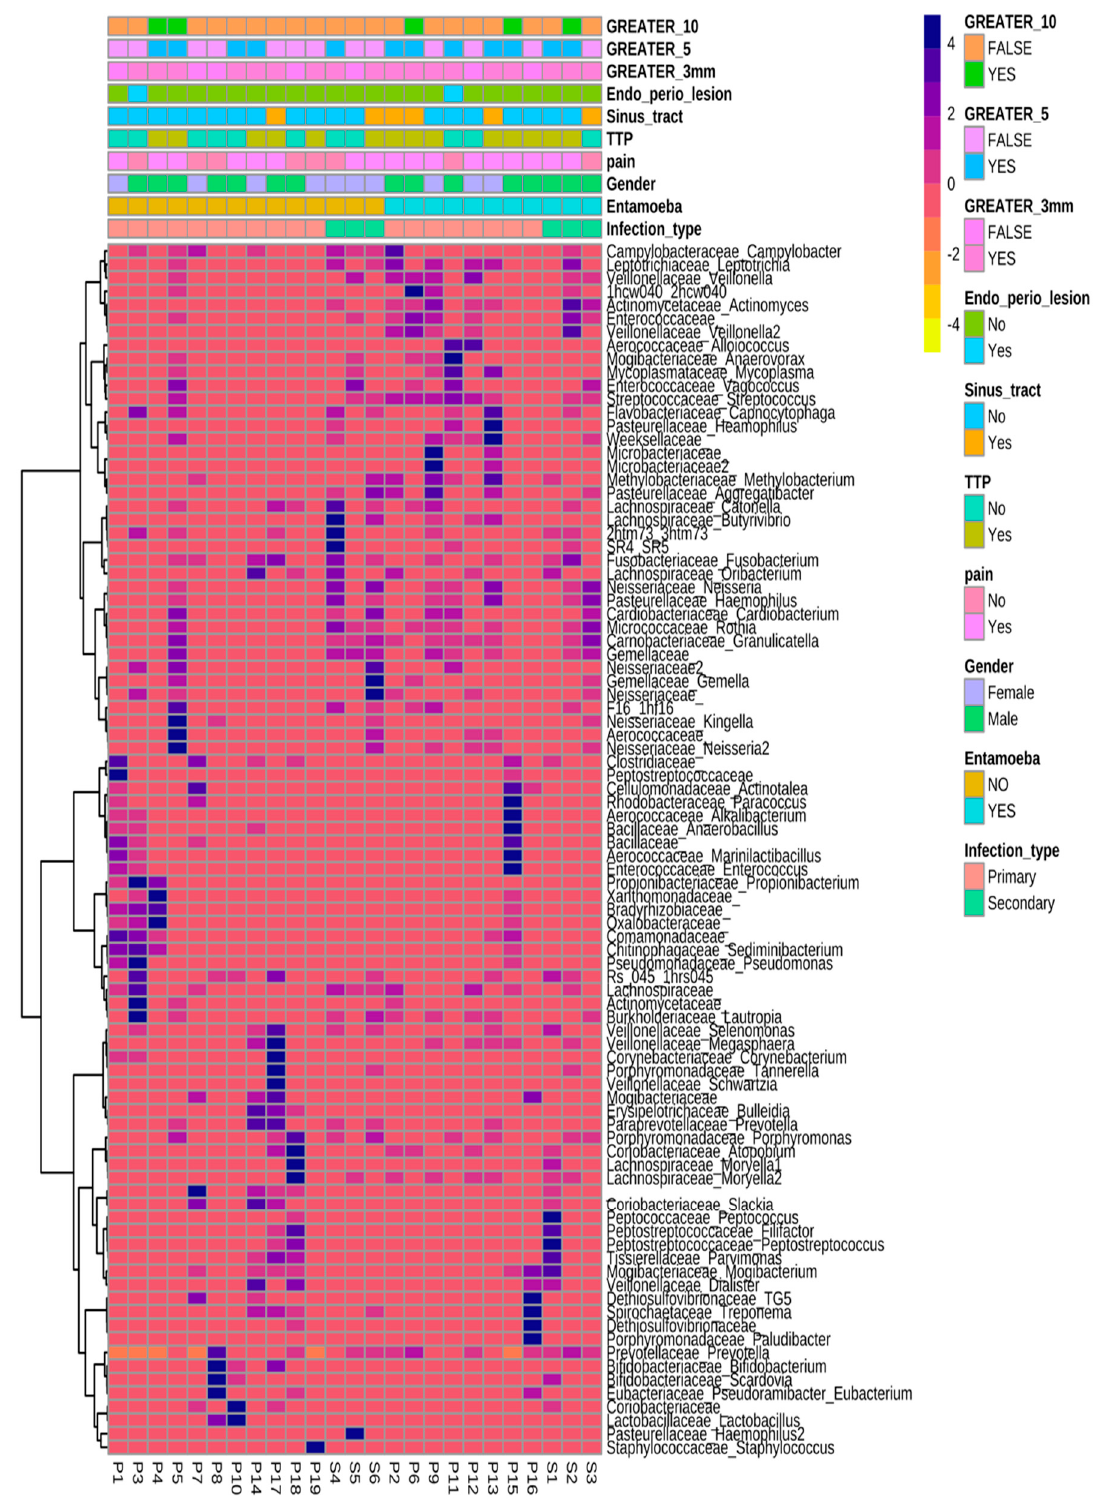
Figure 3. Ward clustered, genus-level heatmap aligned by sample identity and sample metadata by infection type and entamoeba status. Abundant clusters for secondary infections were noted in the first major cluster, with greater diversity and richness observed for primary infections at this taxonomic level. Greater x denoted lesion sizes ( > 3, > 5, > 10 mm, respectively), Tenderness to percussion (TTP). Scale represents relative log2 expression ( − 4 to 4). P, primary and S, secondary.